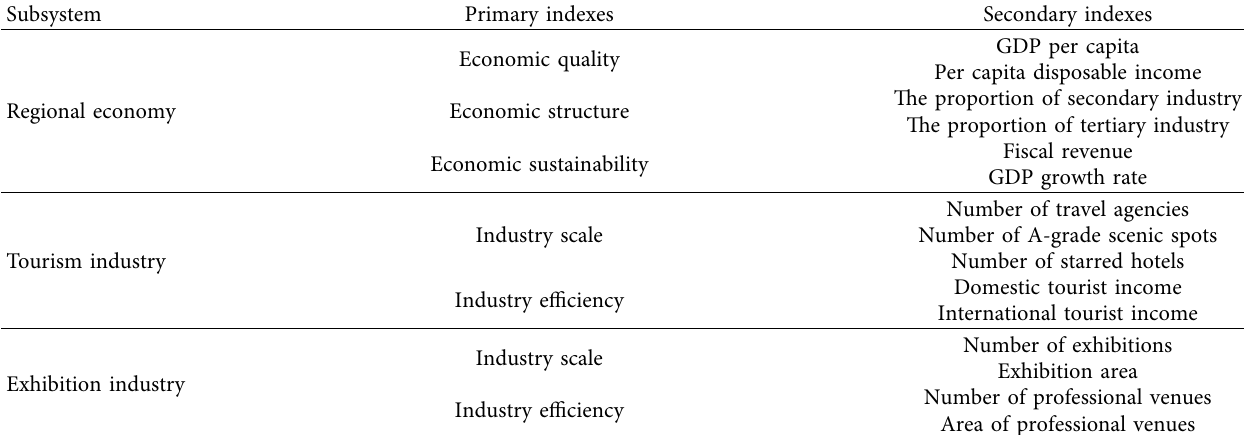
Table 1: The index